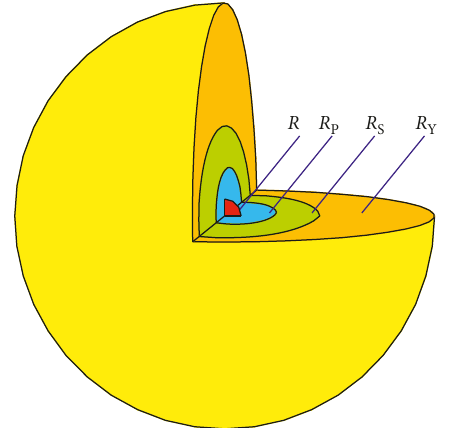
Figure 3: Dynamic system stereomodel of coal and rock.